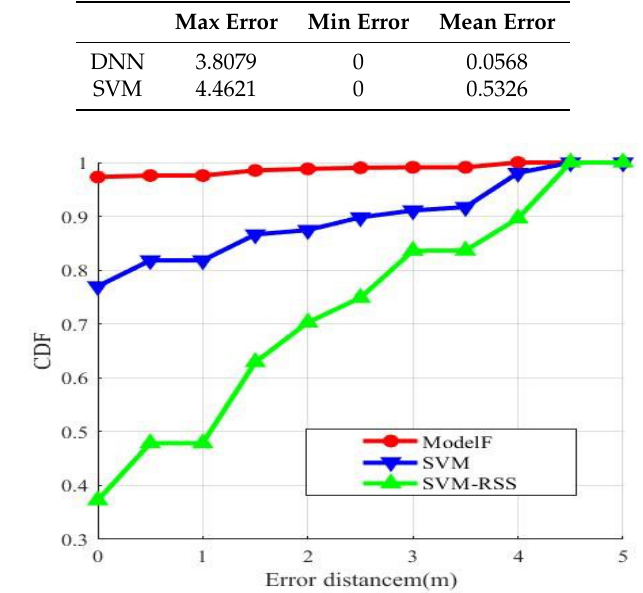
Figure 7. Localization precision of different classifier.